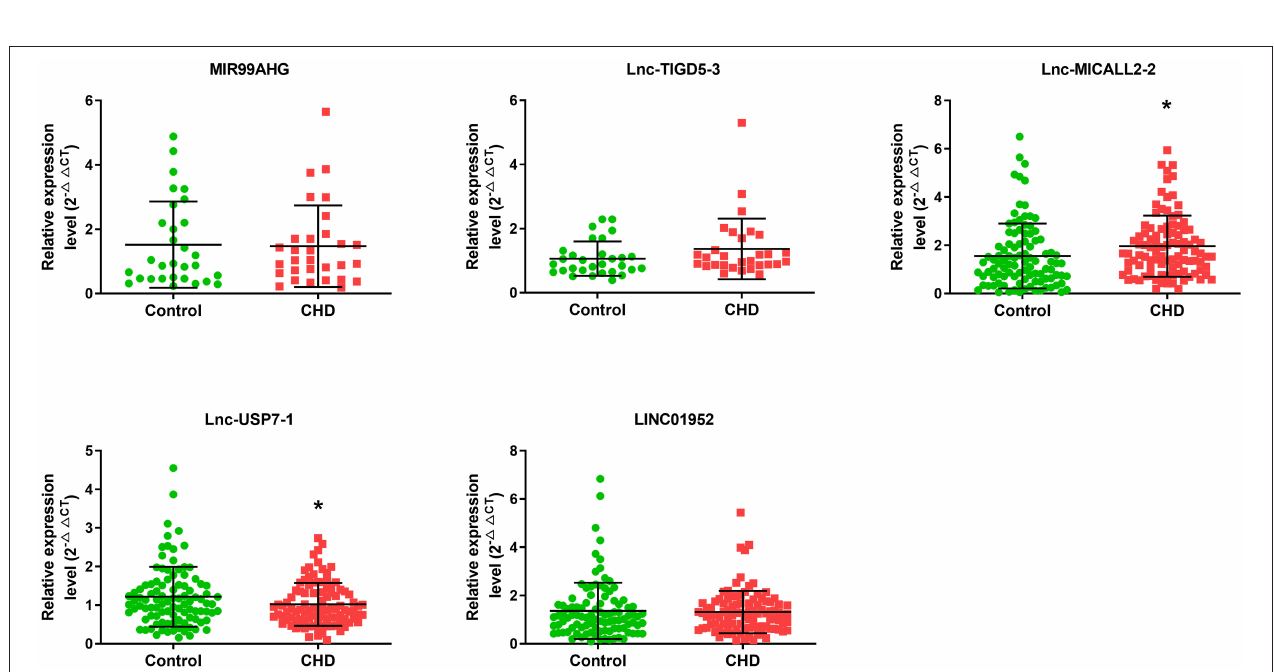
FIGURE 2 | Comparison of the expression levels of lncRNAs between the CHD and non-CHD subjects. Five differentially expressed lncRNAs were validated by qRT-PCR. Data are expressed as means ± SD, ( n = 30–100/group), * p < 0.05. Student t -test was used for all comparisons.